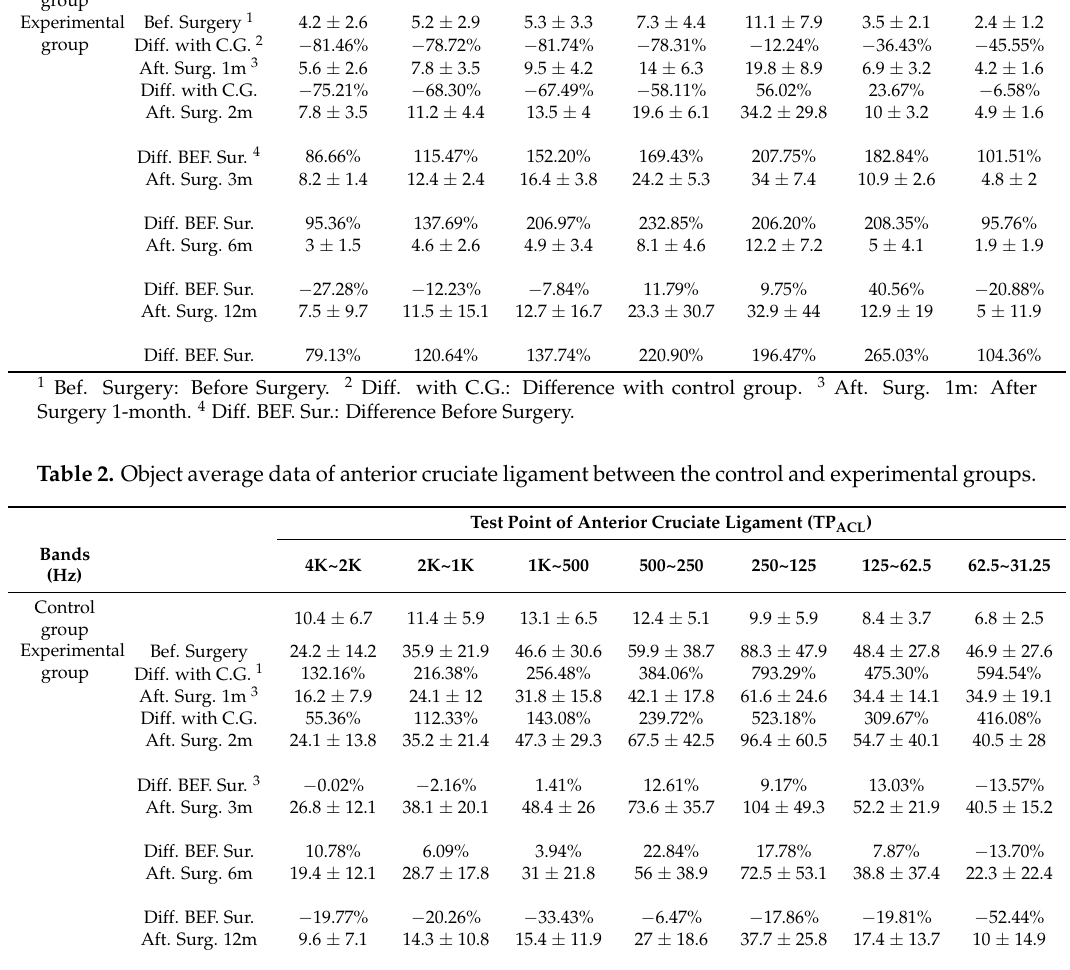
Experimental group